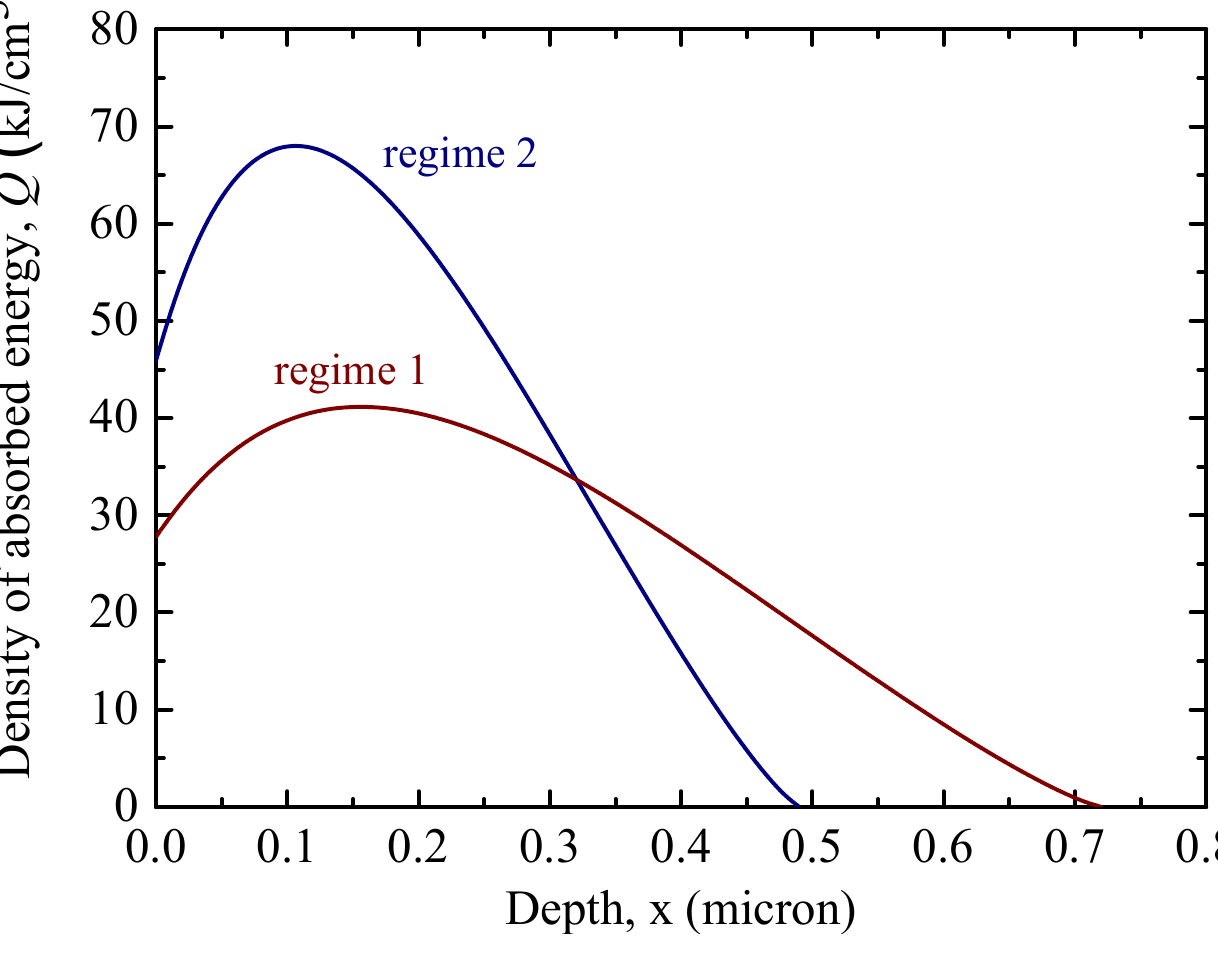
Figure 5. Distribution of the energy density Q absorbed by the boron coating from the beam of accelerated electrons versus depth for two regimes. The beam parameters are τ e = 500 ms, regime 1: j e = 0.5 A/cm 2 , E e = 8 keV, regime 2: j e = 0.75 A/cm 2 , E e = 6 keV.